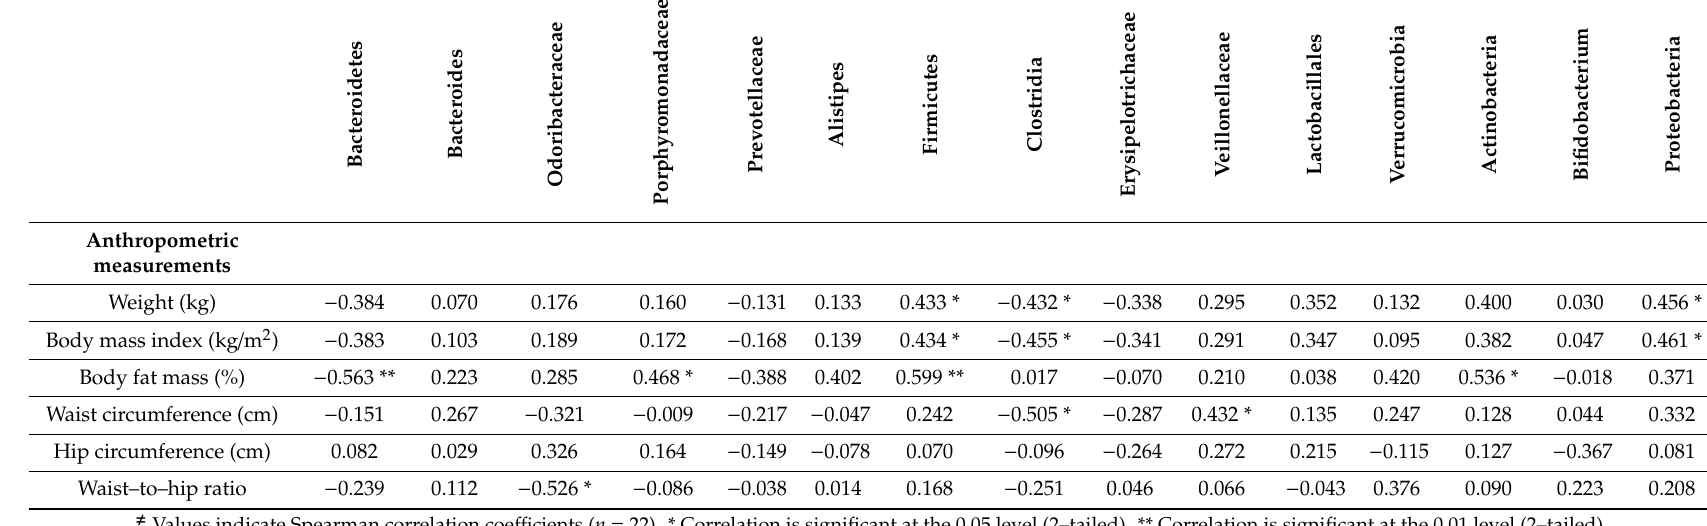
Table 3. Correlations between changes in anthropometrical measurements and fecal microbiota composition at phylum and subphylum level (cid:44)